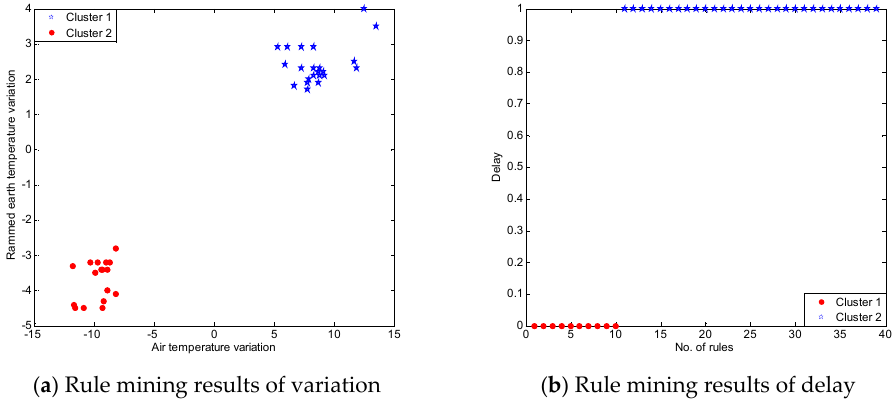
Figure 12. Rule mining results for Ming Dynasty Great Wall dataset.